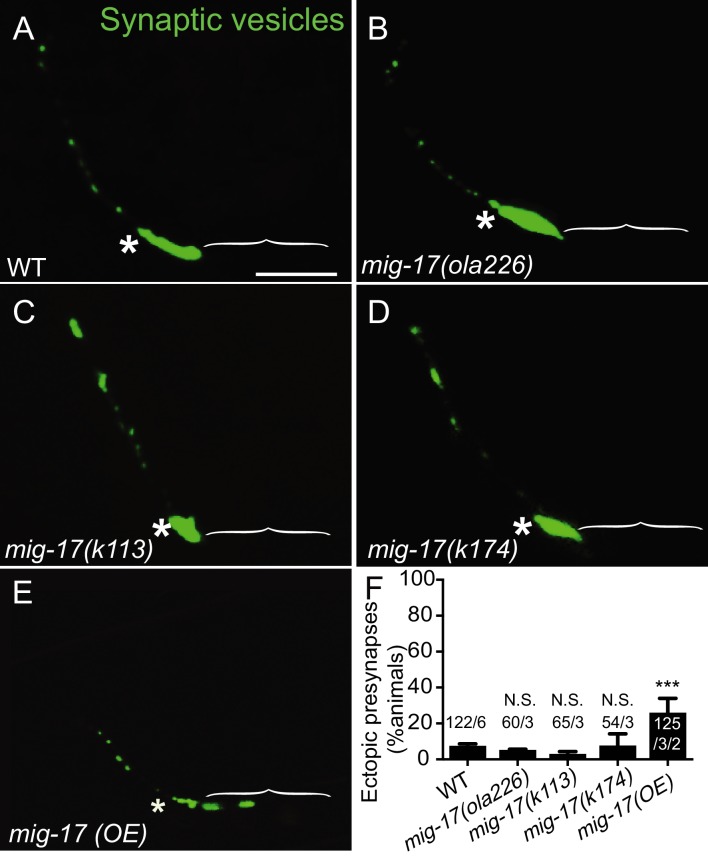
Synaptic phenotypes in mig-17 alleles.(A–E) Confocal micrographs of the AIY synaptic vesicle marker GFP::RAB-3 (green) in the wild type (A), mig-17(ola226) (B), mig-17(k113) (C), mig-17(k174) (D) and mig-17 overexpression in wild-type background (mig-17(OE)) (E). The scale bar in (A) is 10 μm and applies to all panels. Brackets mark the Zone 1 region, and asterisks indicate the Zone 2 region. (F) Quantification of the percentage of adult animals with ectopic synapses in the AIY Zone 1 region for the indicated genotypes. In the graph, the total number of animals (N) and the number of times scored (n) are indicated in each bar for each genotype as N/n. Note that over-expressing mig-17 in wild type animals (E) resulted in mild but significant phenotype of ectopic synapses in the Zone 1 region of AIY (F). The data demonstrate that overexpression of mig-17 phenocopies cima-1(wy84) loss-of-function allele, in support of our model that the mig-17 acts in opposition to cima-1. Statistical analyses are based on one-way ANOVA by Tukey’s multiple comparison. Error bars represent SEM, N.S.: not significant or p>0.05, ***p<0.001.